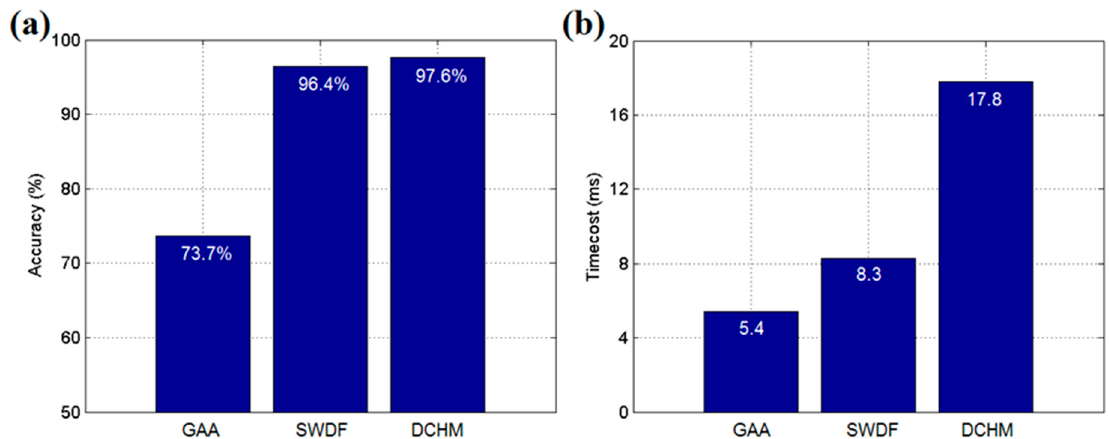
Figure 9. ( a ) Average accuracy of each algorithm in the experiments; ( b ) Average time cost of each algorithm in the experiments.